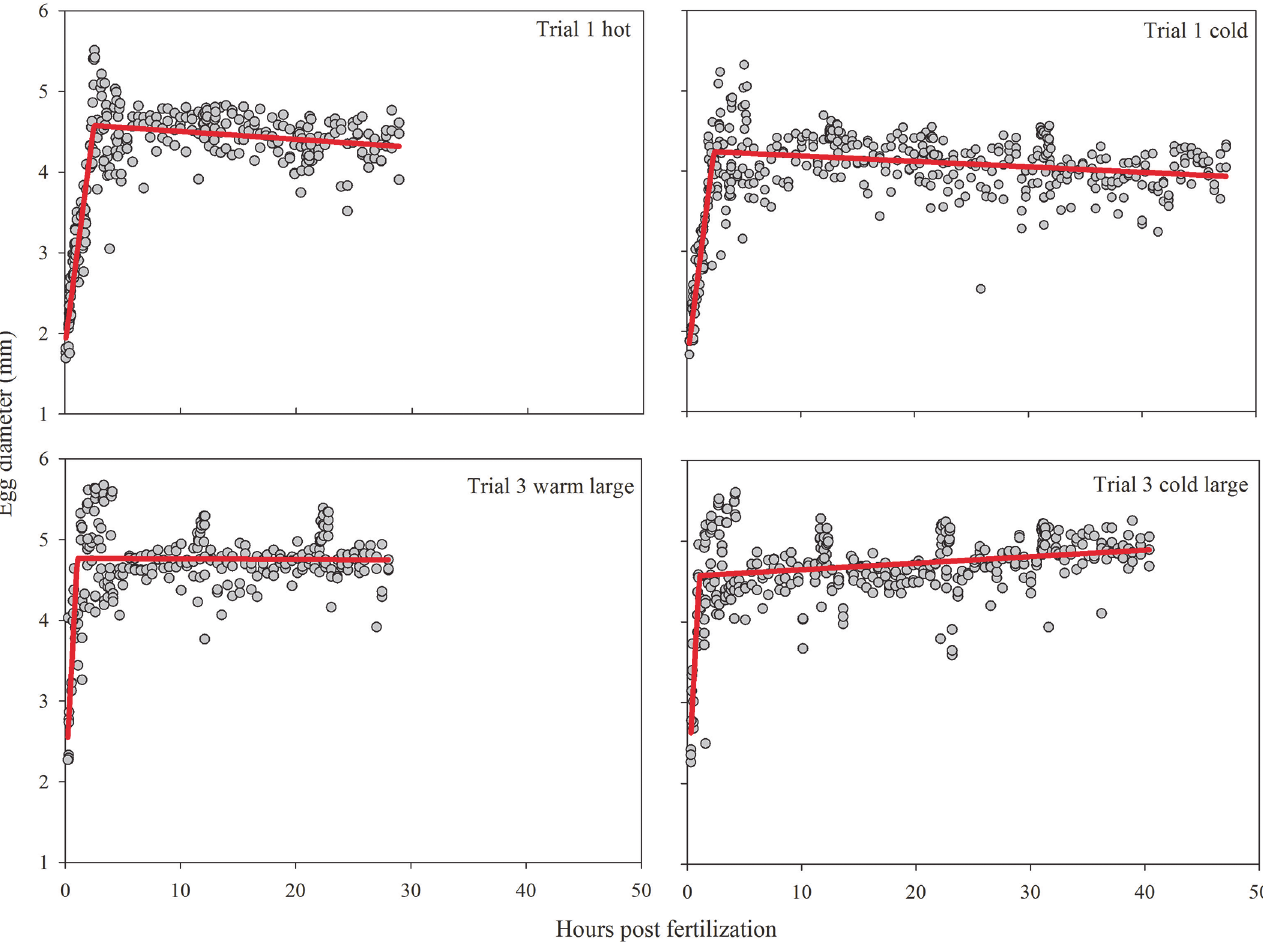
Fig 1. Grass carp egg diameter (mm) for both temperature treatments of trials 1 and 3 large. Trial 2 followed the same general trends as trial 1 and trial 3 small was similar to trial 3 large. The breakpoint of the red line indicates where water hardening occurs and eggs stop